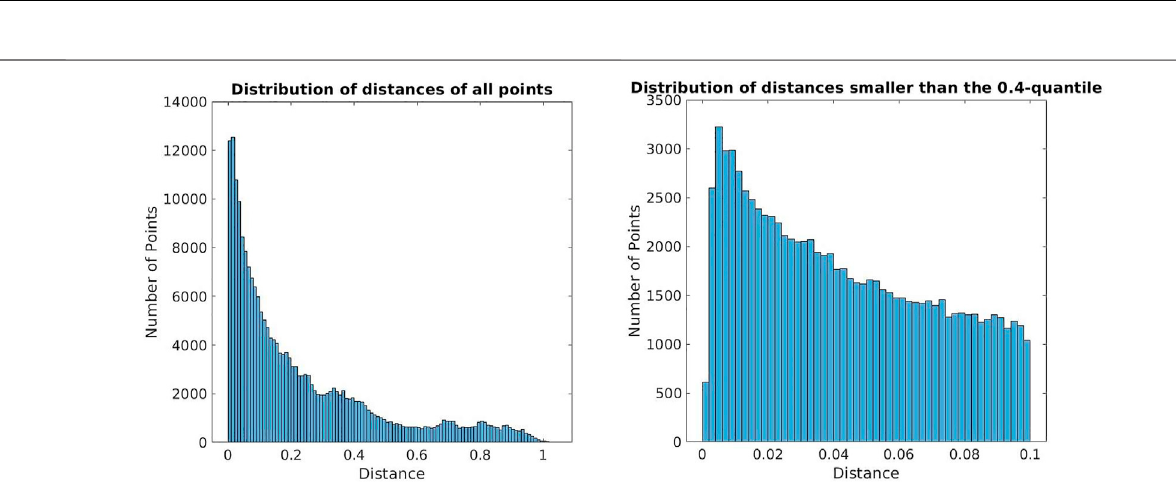
Frontiers in Robotics and AI |